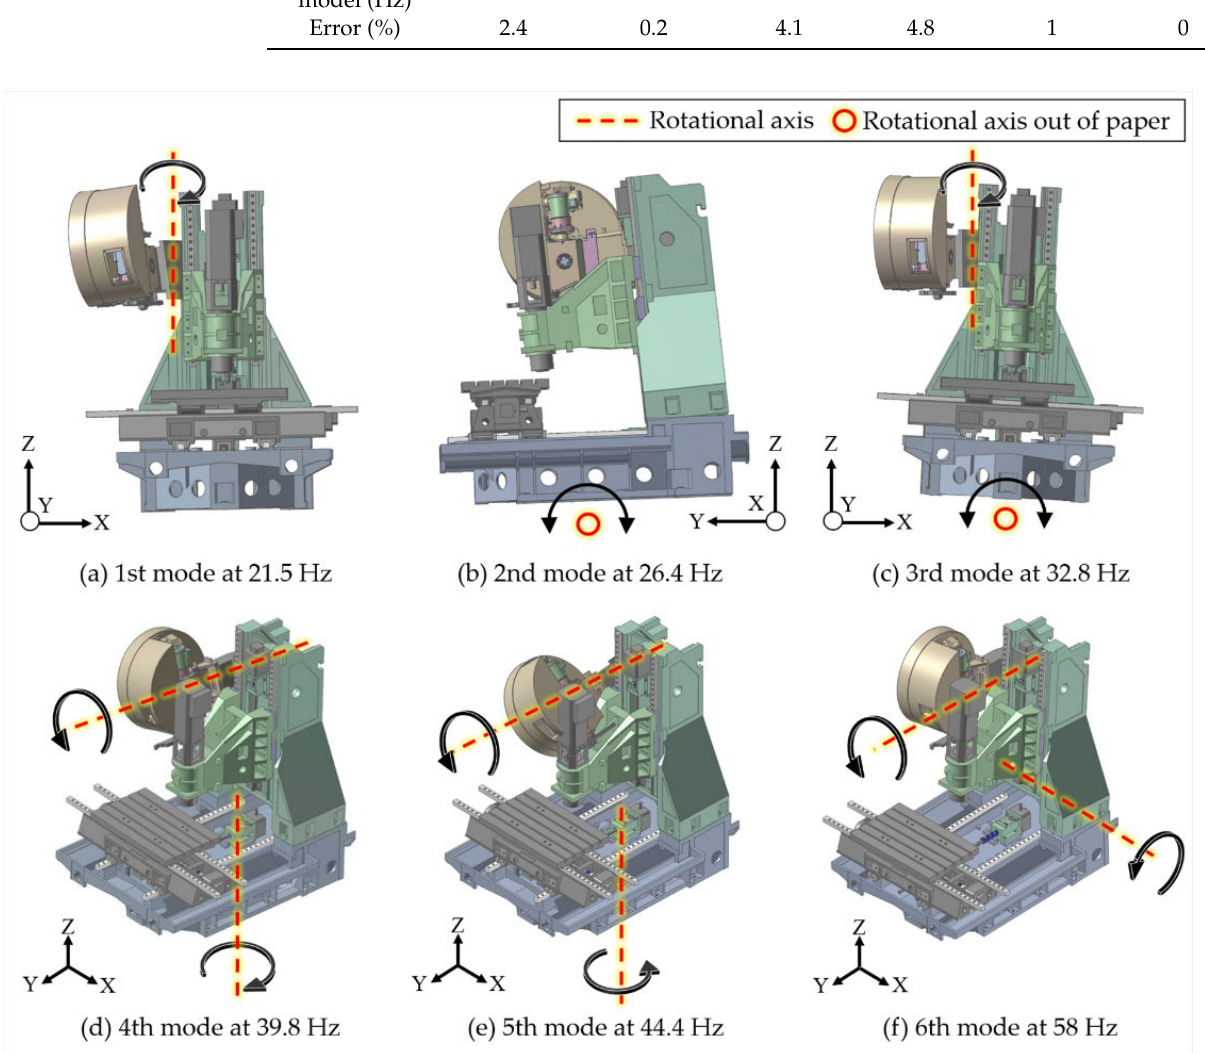
Figure 14. Simulated with the first six natural frequencies and mode shapes.